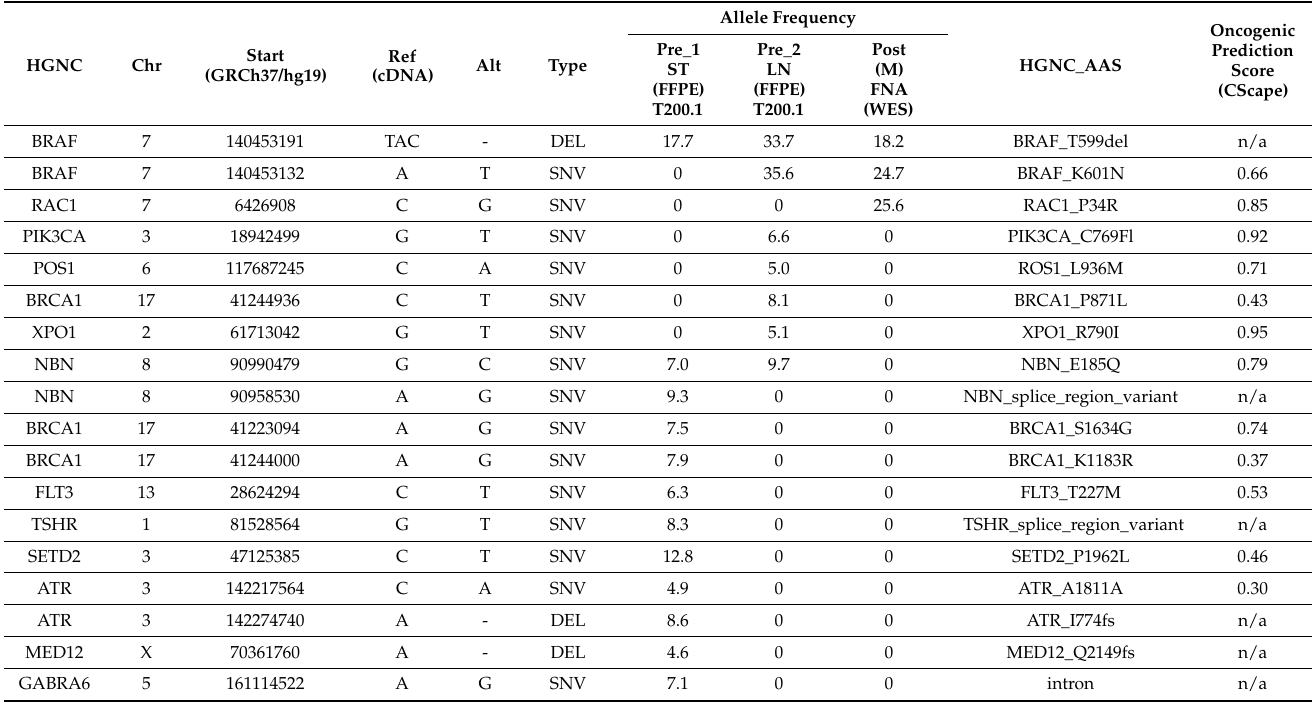
Table 1. Somatic mutations captured by T200.1 and WES